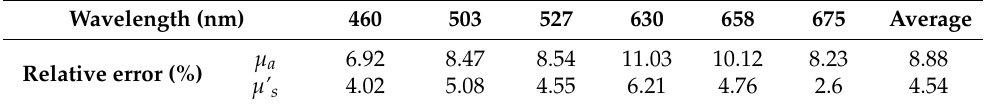
Table 2. Average error of the measured optical properties at six